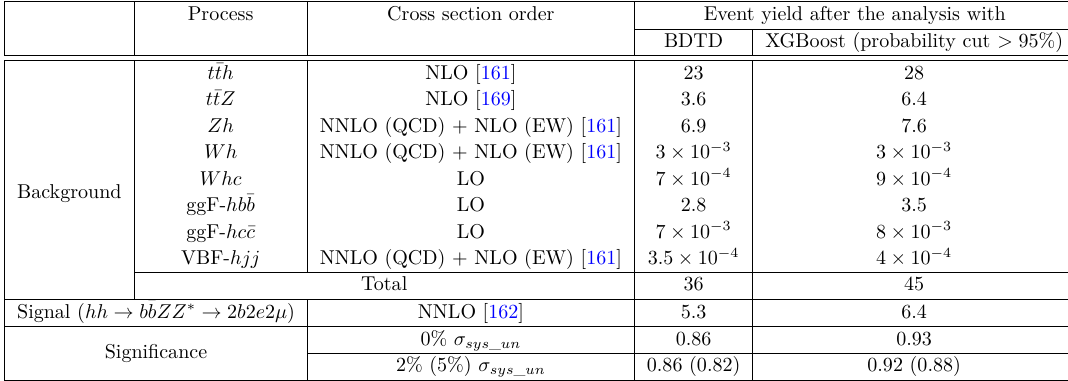
Table 8 . The signal and background yields at the HE-LHC along with the signal significance for the b ¯ bZZ ∗ → 2 b 2 e 2 µ channel from the analysis using the BDTD and the XGBoost classifiers.